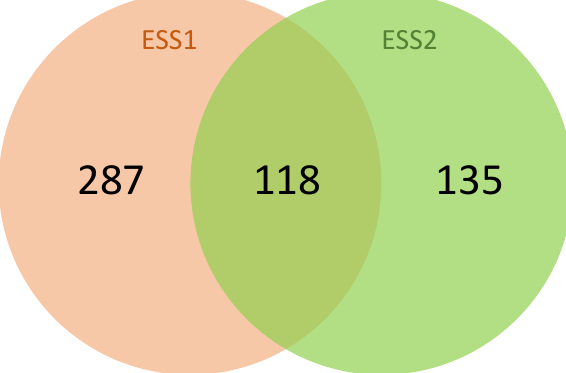
Figure 2. Venn diagram depicting the number of genes associated with eggshell strength at Time Point 1 (ESS1), at Time Point 2 (ESS2), and their